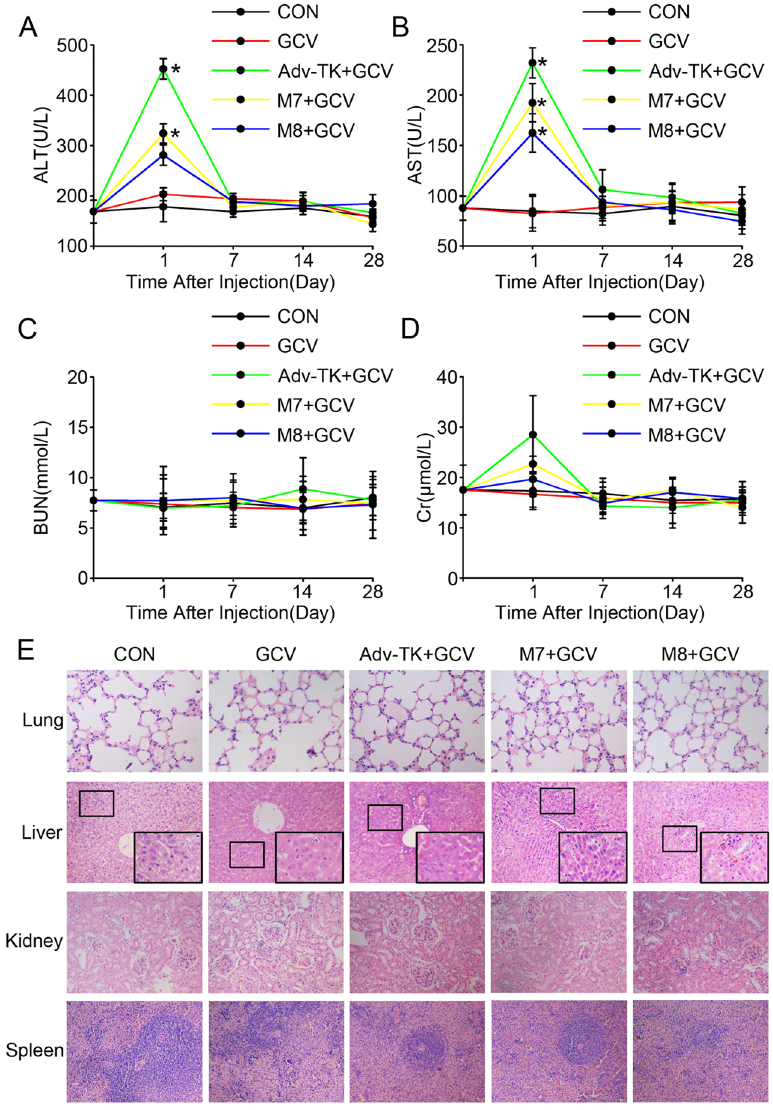
Fig 6. Evaluation of the safety profiles of Adv-TK, M7 and M8 in immunocompetent and permissive Syrian hamsters. Hamsters were randomly assigned into five groups and injected with saline, GCV, Adv-TK, M7 or M8 (1.0×10 12 vp/kg) once daily for five consecutive days. 12 hours later, the hamsters were injected i.p. once daily for five consecutive days with GCV (50 mg/kg/d) in 100 μ L of saline. The hamsters were sacrificed at the indicated time. Blood and tissues were harvested for the detection of haematological indices and histopathological analyses. A ) Alanine aminotransferase (ALT). B ) Aspartate aminotransferase (AST). C ) Blood urea nitrogen (BUN). D ) Creatinine (Cr). ( * P < 0.05). E ) The main tissues and organs (lung, liver, kidney and spleen) were harvested for hematoxylin and eosin (H&E) staining. Representative histological images of tissues 1 days after virus injection are